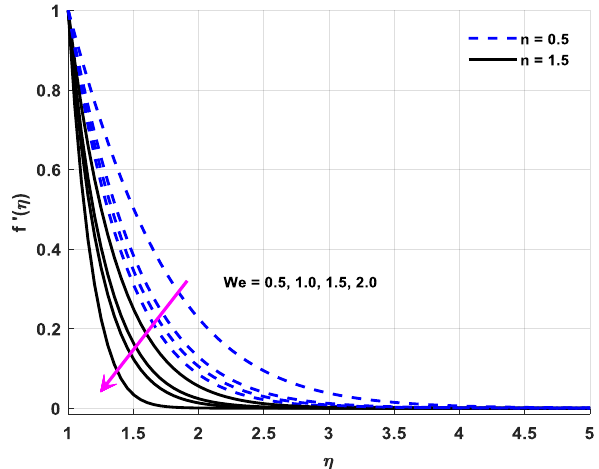
Figure 3. Fluid velocity profile variations owing to changes in We .